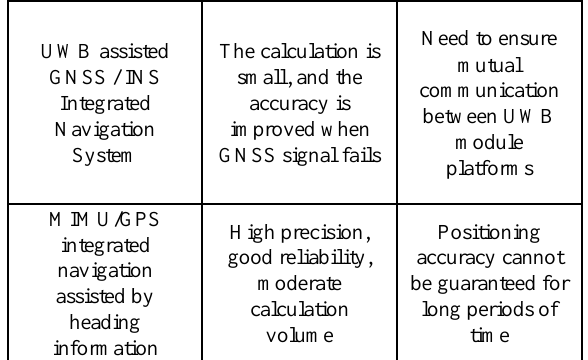
Table 1 . Comparison of research methods of different integrated navigation methods.